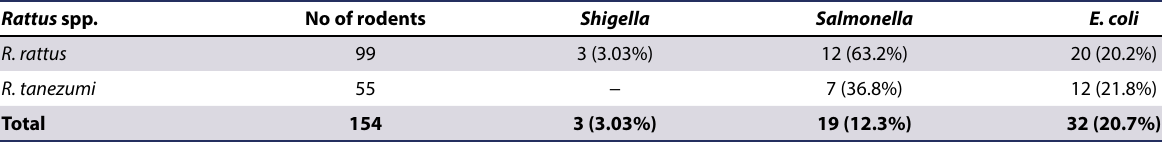
Table V: Number of isolates from sampled farms Farm No of